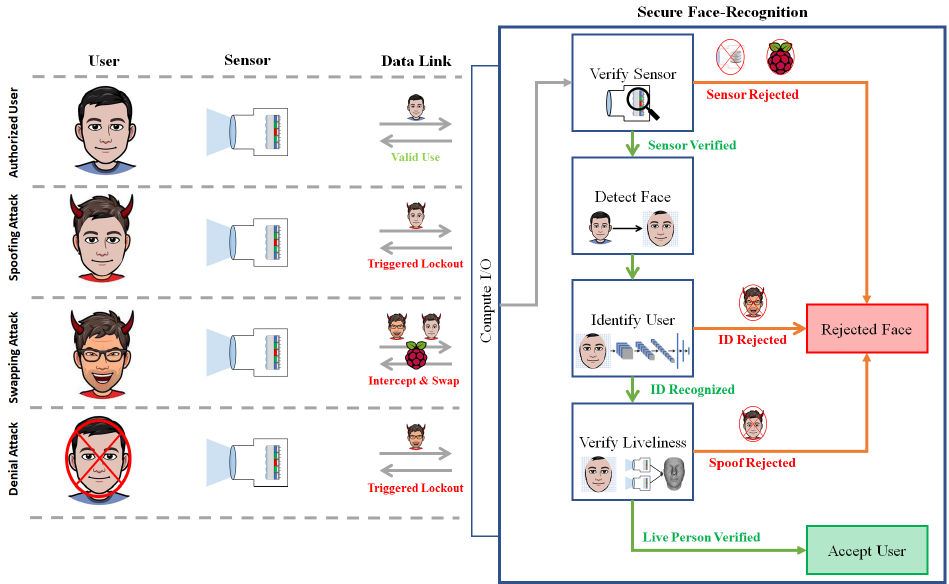
Figure 1. Secure face recognition pipeline with attack vectors. Scenario 1 is authenticating an authorized user. Scenario 2 is spoofing via a physical facsimile. Scenario 3 is spoofing via face-swap- attack. Scenario 4 is denying service by destructively altering